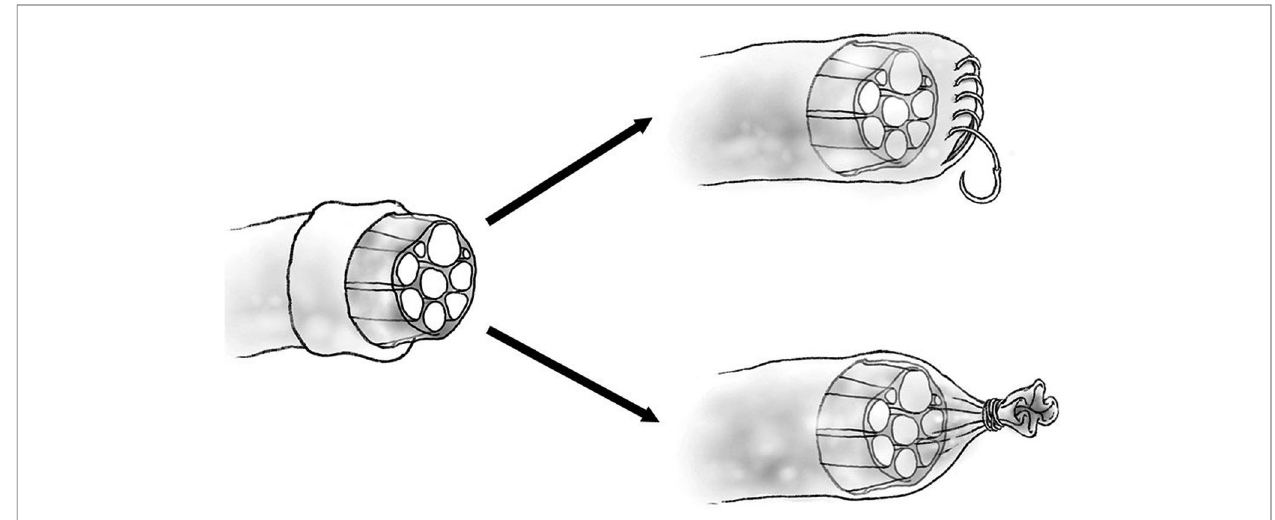
FIGURE 2 | Diagram of epineurial fl ap (top) and epineurial ligature (bottom).